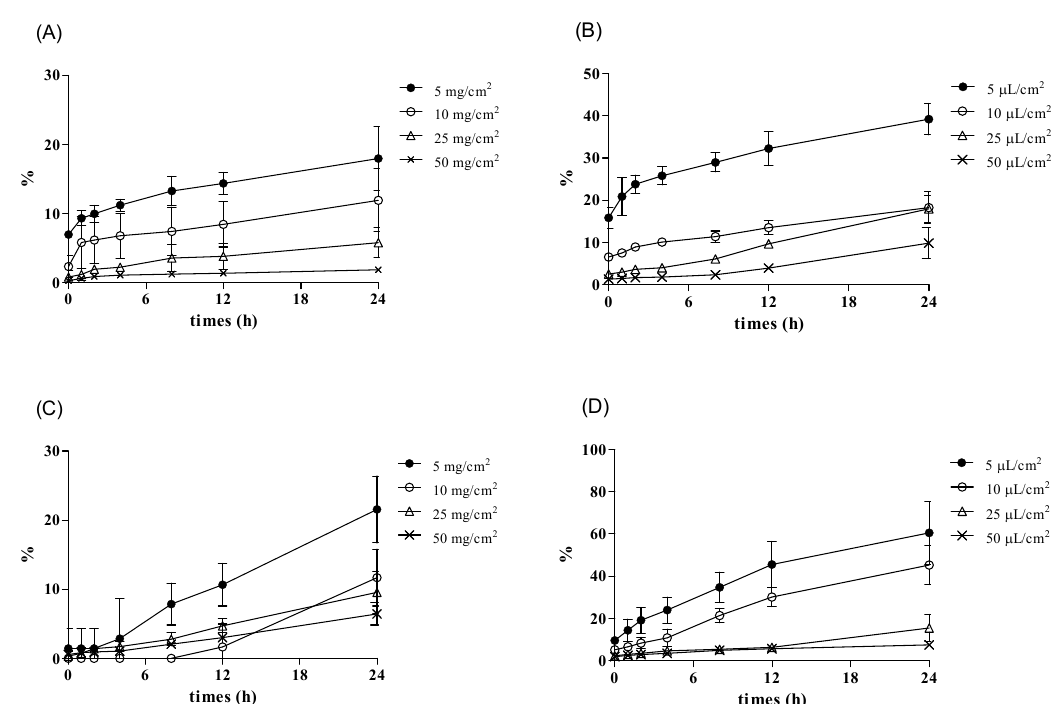
Figure 6. Penetration of caffeine (5, 10, 25, 50 mg or µL/cm 2 ) (mean ± SD). ( A ) Rat (cream), ( B ) rat (solution), ( C ) Micropig ® (cream), and ( D ) Micropig ® (solution).